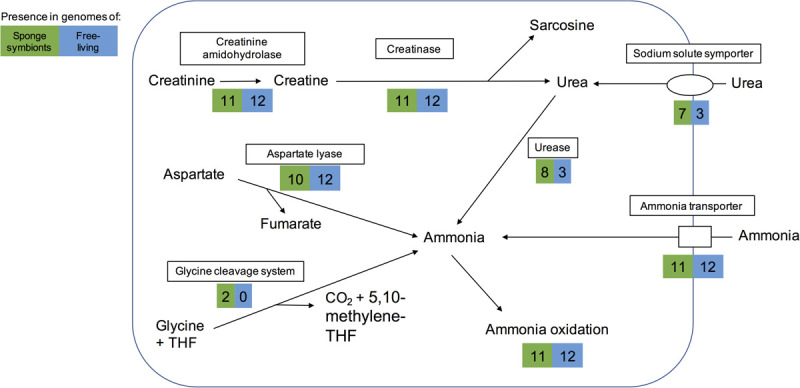
Pathways for generating ammonia in the sponge-associated and free-living Thaumarchaeota. Boxes indicate proteins or pathways. Numbers inside colored boxes represent number of genomes found with the pathway or protein. The maximum number of sponge-associated and free-living MAGs is 11 and 12, respectively. THF, tetrahydrofolate.